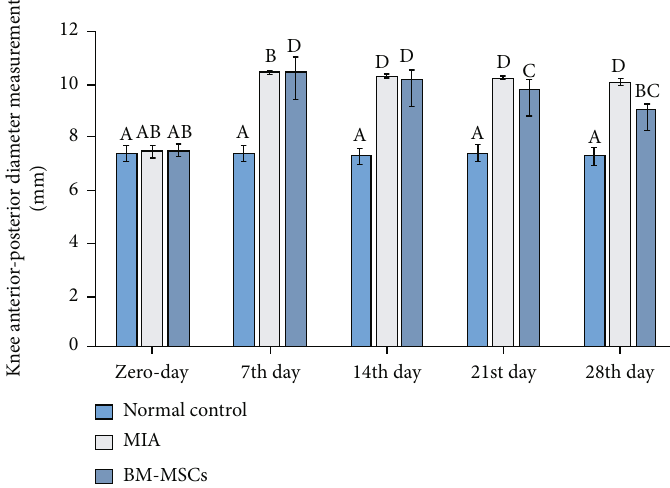
Figure 2: Knee anterior-posterior diameter measurements in normal control, MIA, and MIA +BMMSC groups. At each period, the means, which have di ff erent symbols (letters), are signi fi cantly di ff erent at P < 0 : 05 .